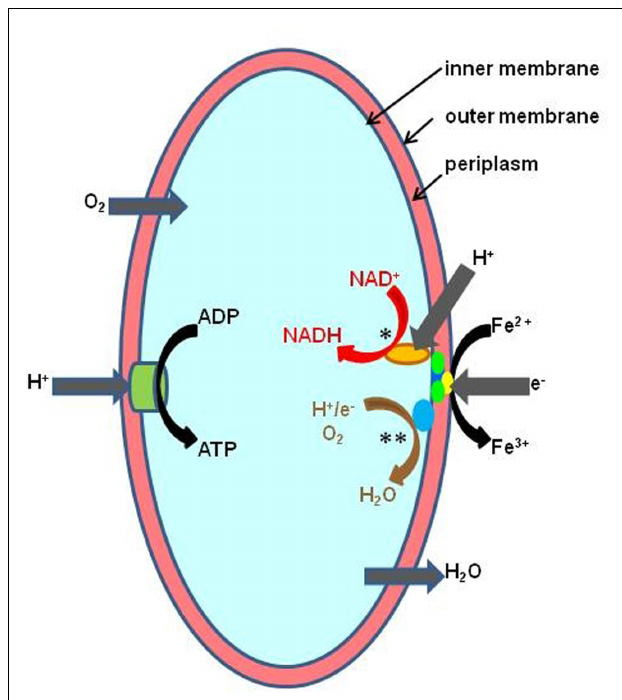
FIGURE 1 | Schematic representation of ferrous iron oxidation by the Gram-negative autotrophic acidophile, At. ferrooxidans . Controlled influx of protons is used to generate ATP via the membrane-bound ATP synthetase complex (ATPase). Iron oxidation is mediated by a cytochrome located on the outer membrane and electrons transferred via periplasmic cytochromes and rusticyanin either to a terminal oxidase (“downhill pathway,” indicated in brown text and by **) where they are used to reduce oxygen, or used to reduce NAD + (“uphill pathway,” indicated red text and by *) in a reaction also driven by the proton motive force across the inner membrane (Bonnefoy and Holmes,